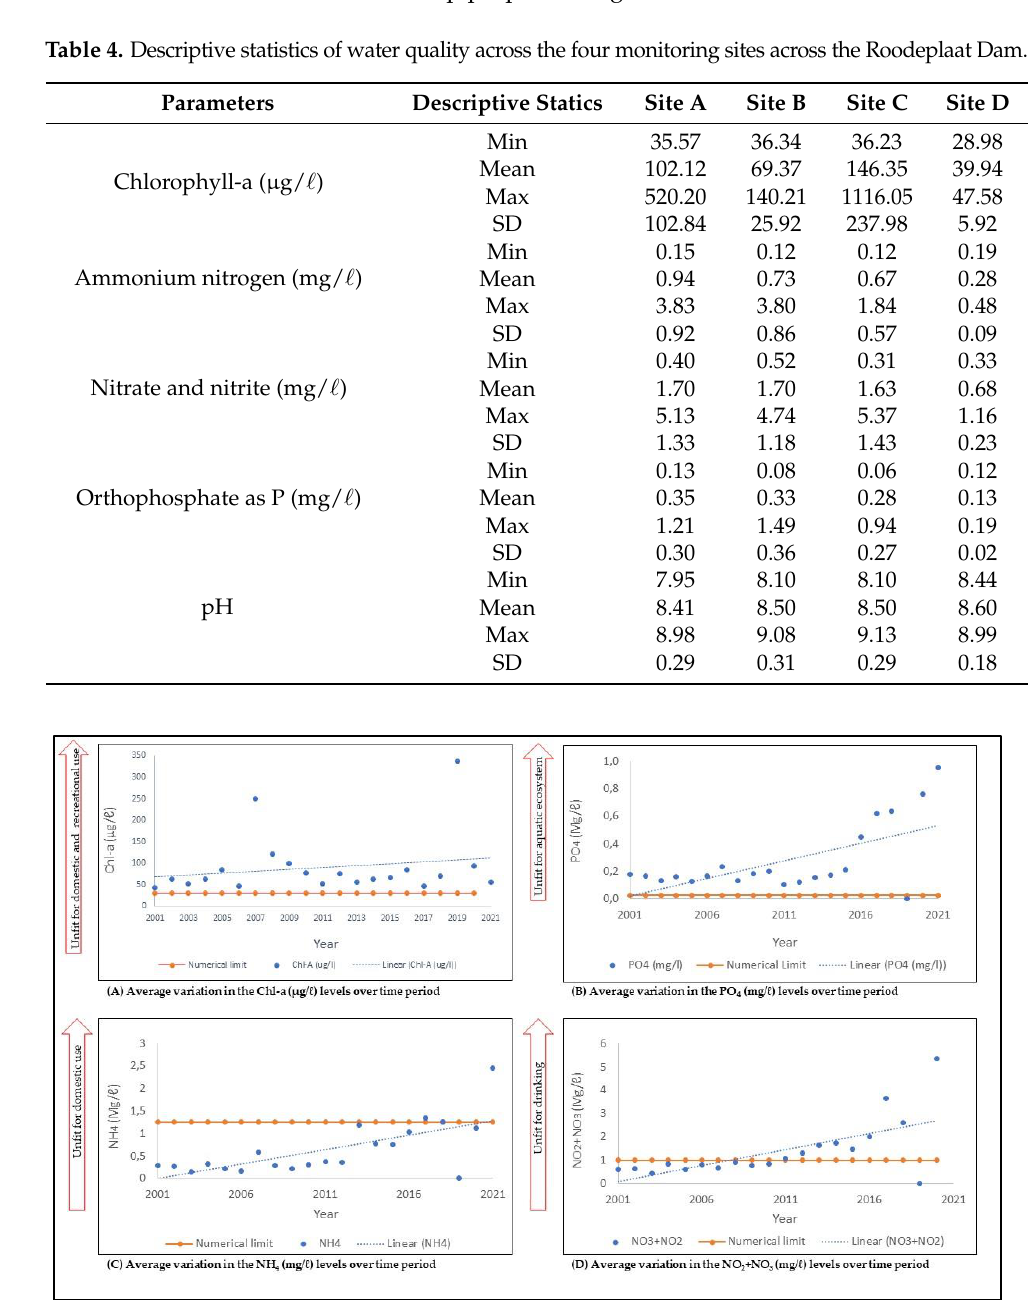
Figure 2. Annual mean variations of selected water quality parameters (( A ) chlorophyll-a levels, ( B ) orthophosphate levels, ( C ) ammonium nitrogen levels, ( D ) nitrite and nitrate levels) across the longitudinal zone of the Roodeplaat Dam compared to the numerical limits of the gazetted RQOs of the catchment.